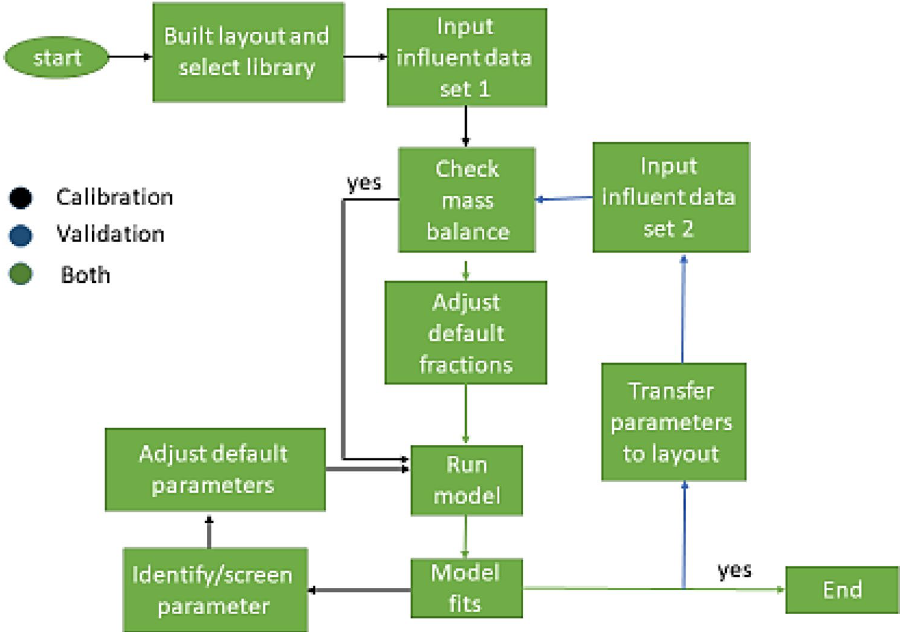
Figure 3. Flowchart for GPS-X model calibration and